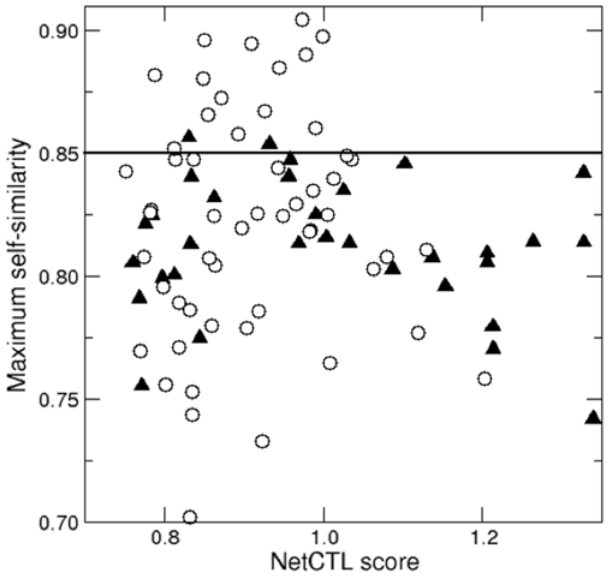
Figure 4. HIV self-similarity and immunogenicity. The NetCTL antigen presentation score (x-axis) and maximal self-similarity (y-axis). Confirmed HIV epitopes are shown as black diamonds and predicted, non-immunogenic HIV peptides are shown as open circles. The 0.85 self-similarity line described in the text divides the y-axis. The region above the line is clearly dominated by non-immunogenic antigens where 88% (14/16) are non-immunogenic compared to the expected frequency of 62% (54/87). This difference is significant (p , 0.05, Fisher’s exact test). Peptide similarity was calculated using the BLOSUM35